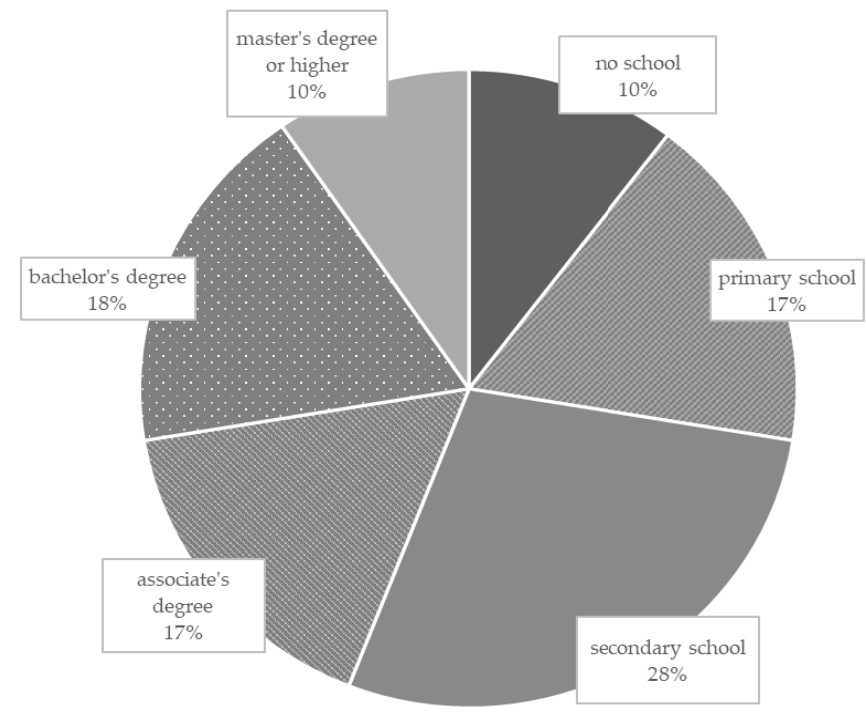
Figure 8. Educational degree for main income earner in Belmopan (n = 395 interviews).